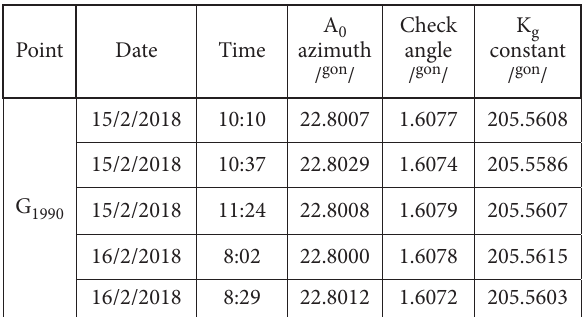
Table 11 lists the parameters needed to calculate the